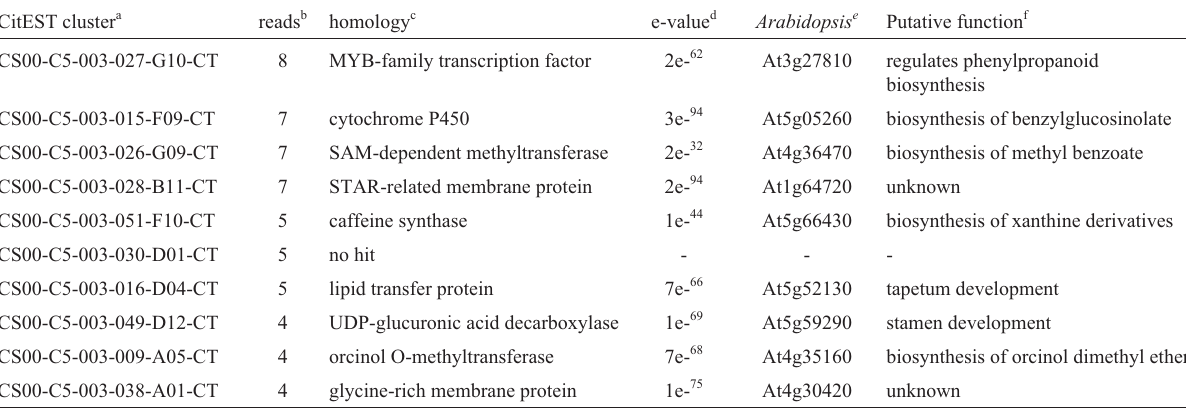
Table 3 - Characterization of the ten most expressed Citrus putative flower-specific transcripts. CitEST cluster